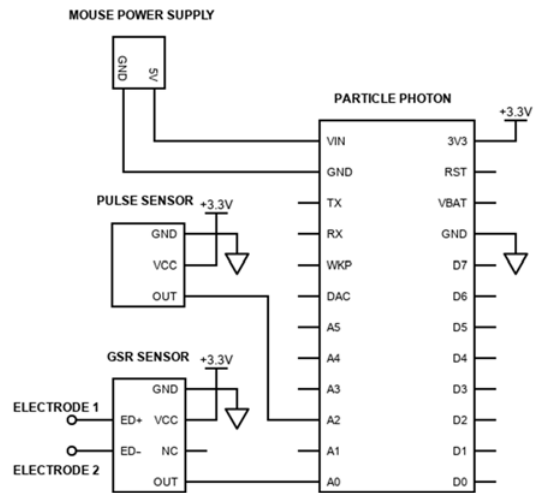
Figure 1. The electrical diagram of the proposed system. The PPG and GSR sensors’ outputs are connected to the analog pins of the development board. The development board is connected to computer mouse’s power pins so that the system is powered by the existing mouse cable.